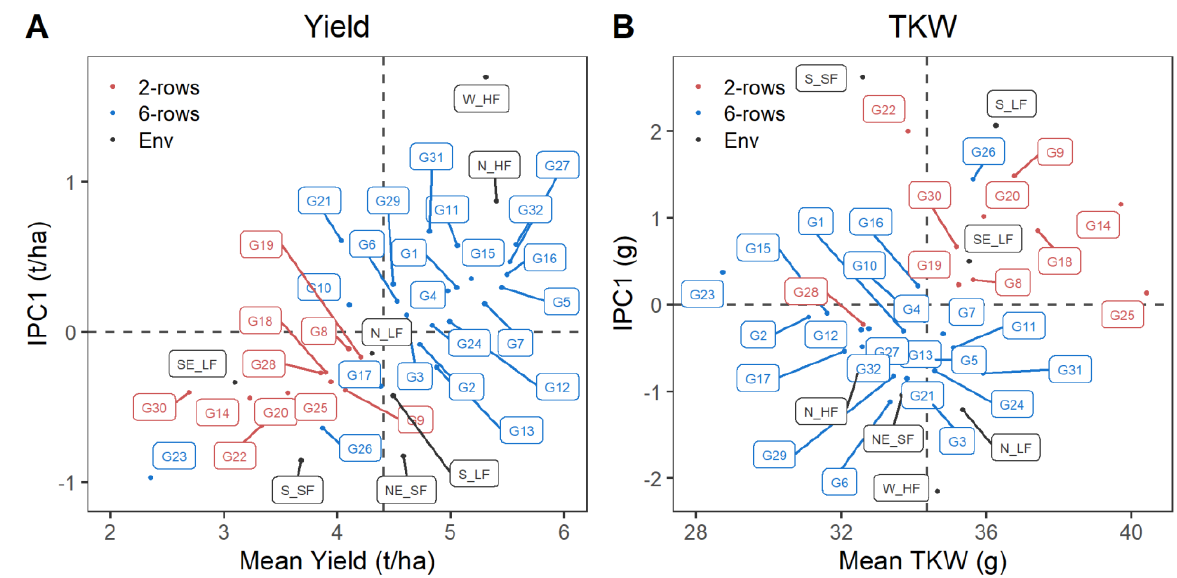
Figure 2. Biplots based on results from additive main effects and multiplicative interaction (AMMI) model with a mean response and IPC1 for ( A ) yield and ( B ) thousand-kernel weight (TKW). Environments are colored in black, and genotypes are colored according to their row type: 6r are in blue and 2r are in red. The overall mean response (4.4 t ha −1 for yield and 34.4 g for TKW) and the overall mean IPC1 score (0 for both traits) are indicated by a dashed line.